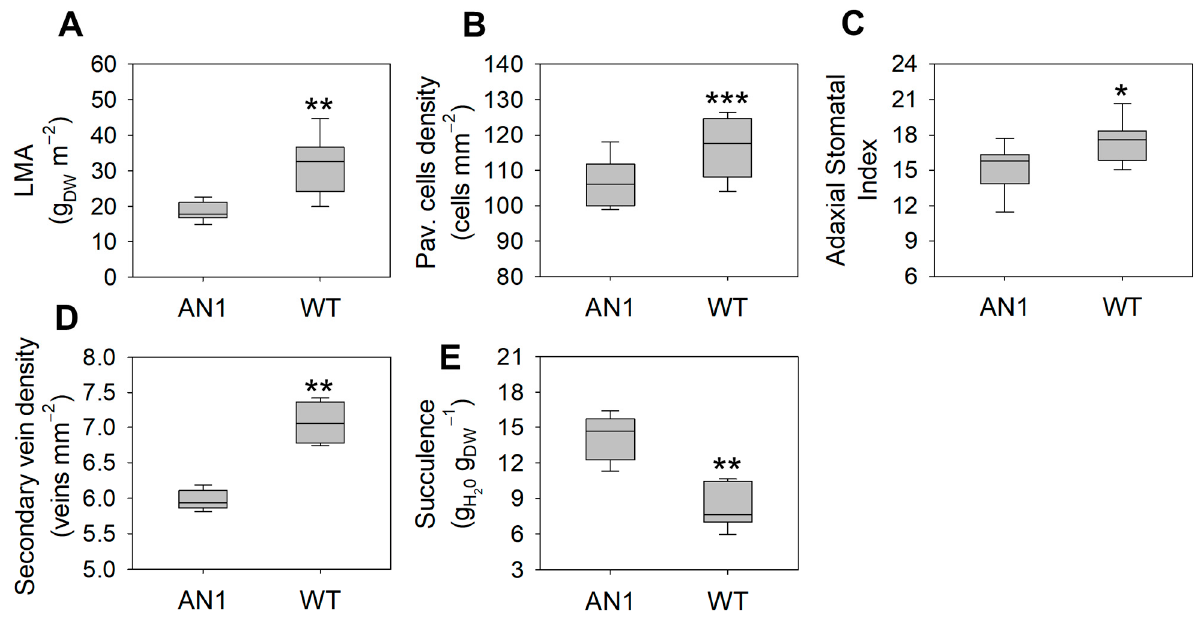
Figure 4. Leaf gas exchanges in AN1 and WT plants. ( A ) CO 2 assimilation rate; ( B ) Stomatal conductance; ( C ) Transpiration rate. Asterisks indicate significant differences according to ANOVA (* p < 0.05; *** p < 0.001).